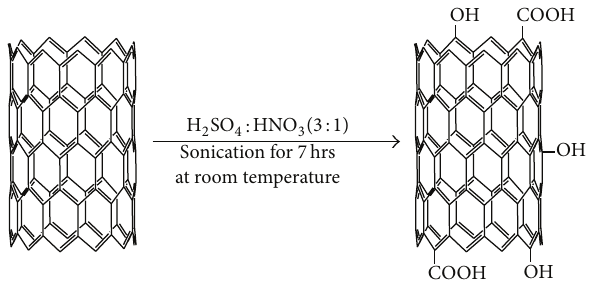
Figure 1: Oxidation of the CNTs by H 2 SO 4 : HNO 3